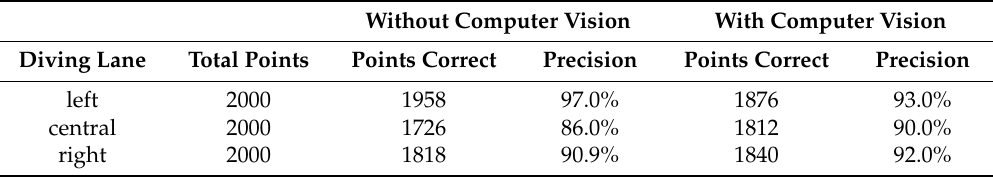
Table 1. Precision test for the mapping system.